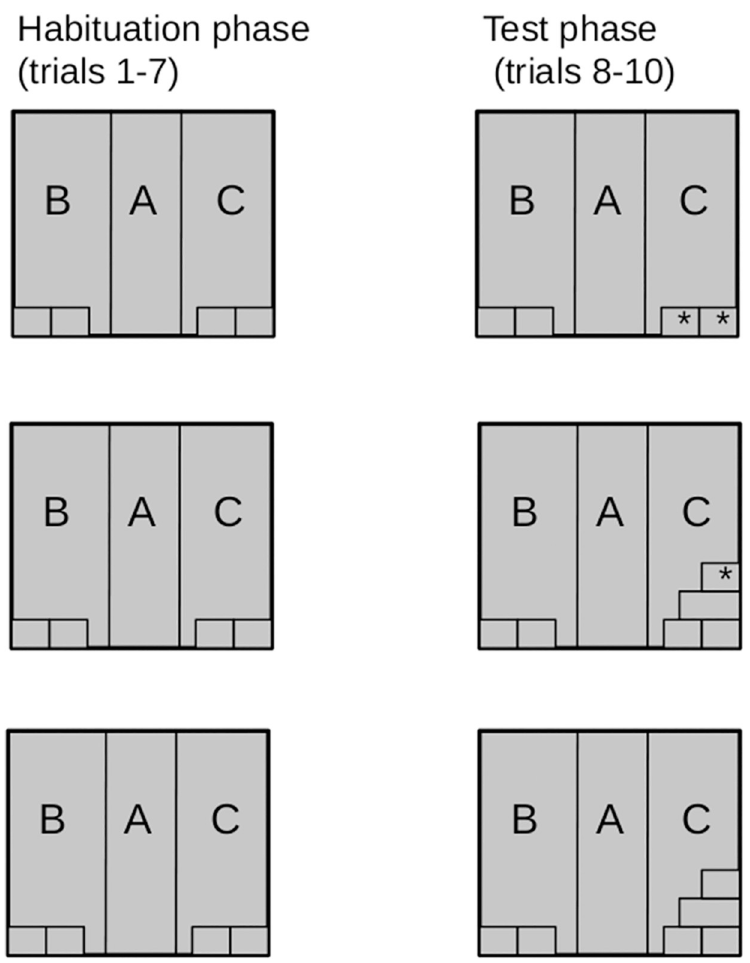
Fig 2. Arrangement of objects in the experimental chamber in each experimental setting. Tunnels marked with � were the see-saw-like tunnels. On the left, the setting during habituation is presented. On the right, the setup during the test days is presented: in the Mov group, two stationary tunnels were replaced by two movable tunnels (zone C). In the MovAdd group, tunnels were added, and the tunnel on the sting was movable (zone C). In the Add group, tunnels were added, and there were no movable